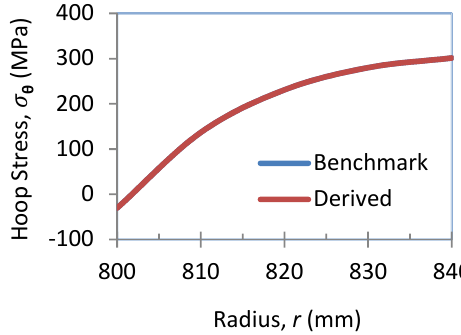
Figure 3. The variation of hoop stress with cylinder radius.